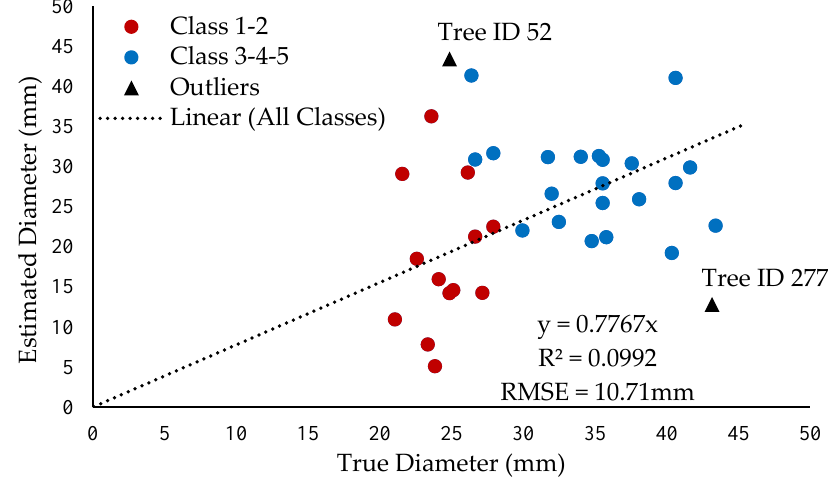
Figure 10. Measured tree diameter compared to estimated tree diameter.